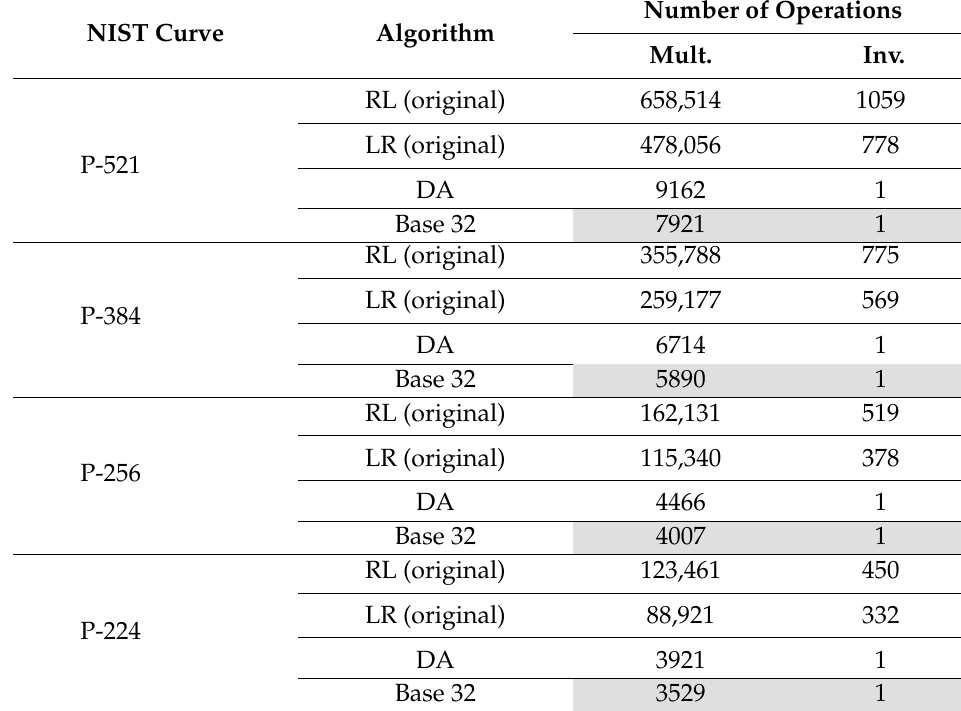
Table 3. Our Work vs. Original Algorithms